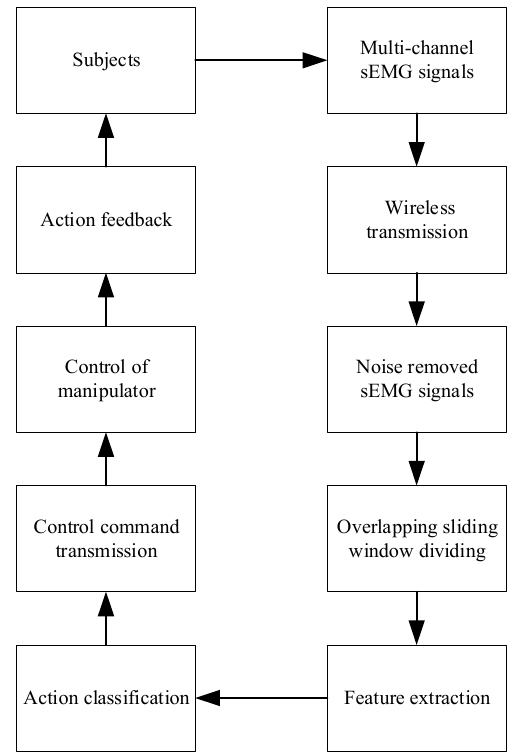
Figure 1. Schematic diagram of the proposed sEMG detection and action recognition system. Raw multi-channel sEMG signals were first acquired and transmitted wirelessly to the host computer. Then the signals were filtered and divided into sliding windows. In each window, feature extraction and action classification were conducted. The output label of the classifier drove the manipulator via the corresponding control command. The action consistency of the subject and the manipulator was observed in real time.